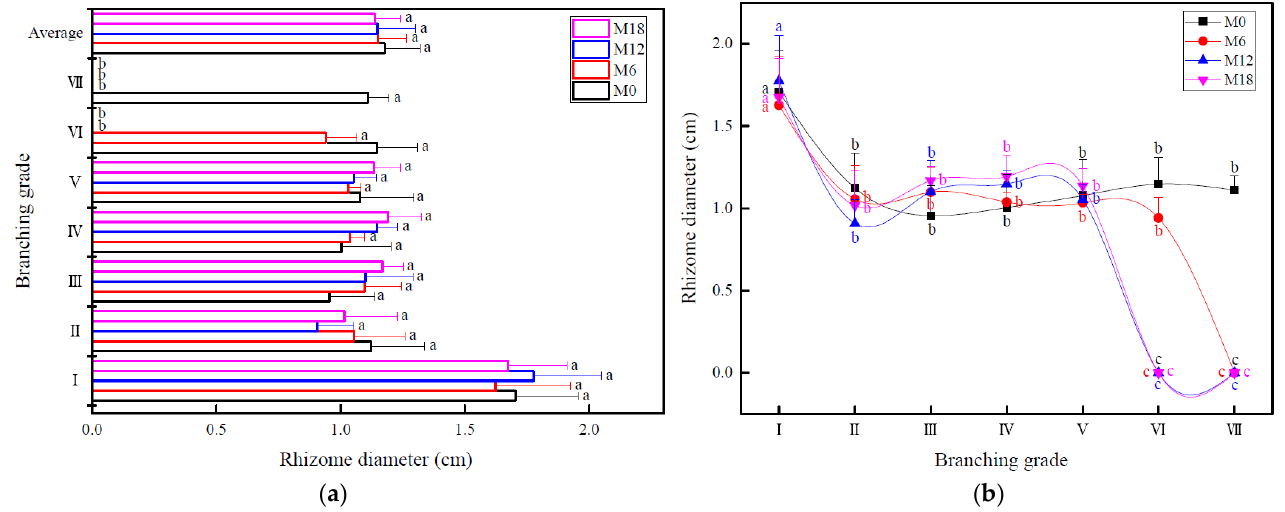
Figure 4. Rhizome diameter. ( a ) Quantitative characteristics of rhizome diameter; ( b ) variation trend of rhizome diameter. Different letters indicate significant differences ( p < 0.05).